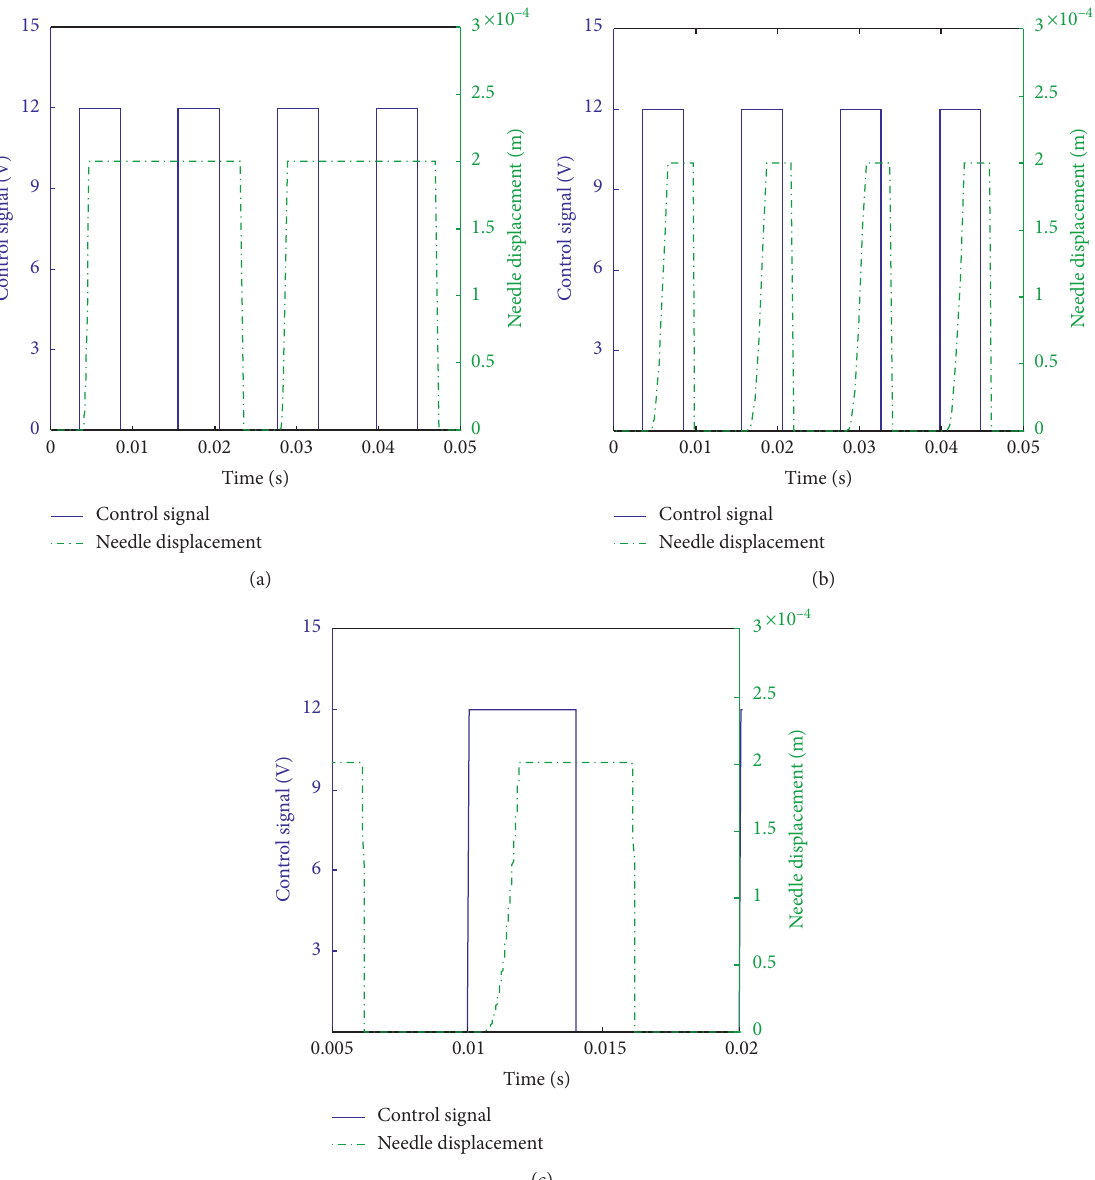
Figure 6: Dynamic displacement of the needle valve with different spring initial tension F